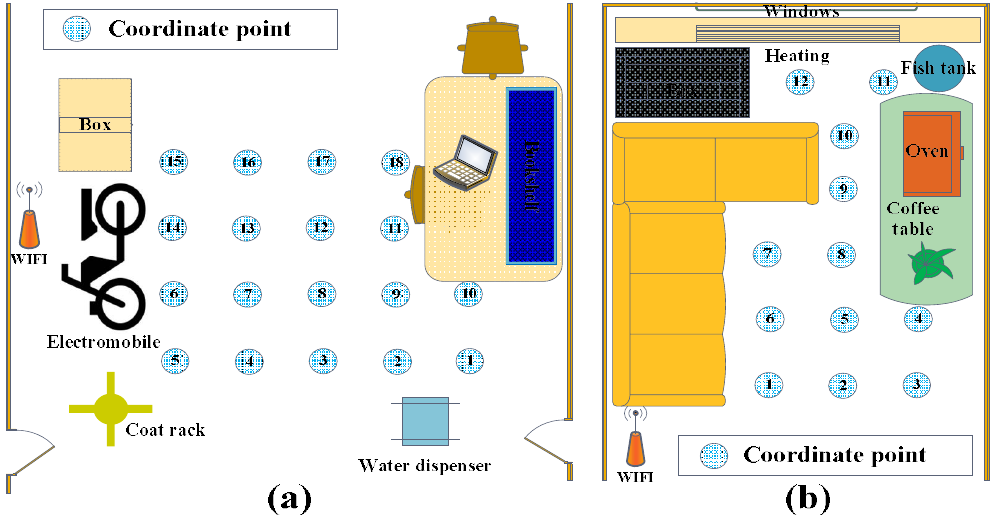
Figure 7. An illustration of the layout of the two experiments. ( a ) The layout of the drawing room 1. ( b ) The layout of the drawing room 2.